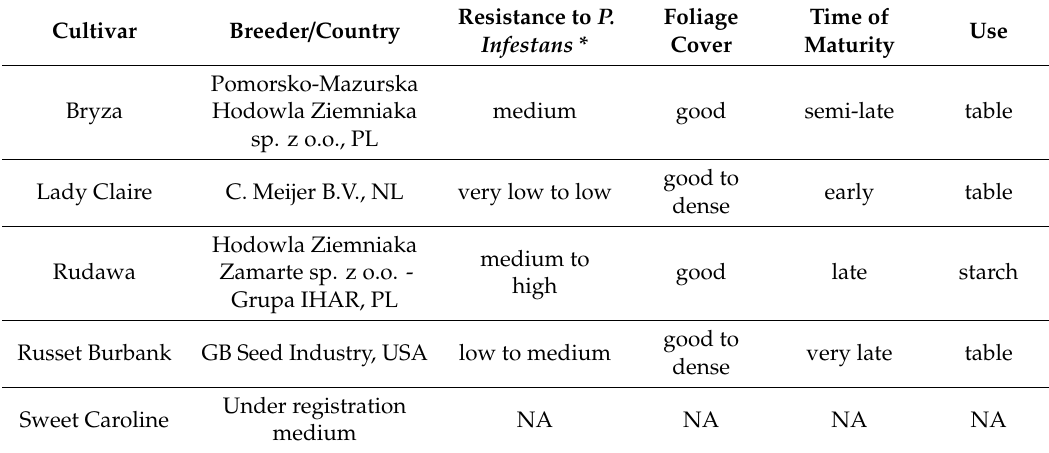
Table 2. Potato cultivar